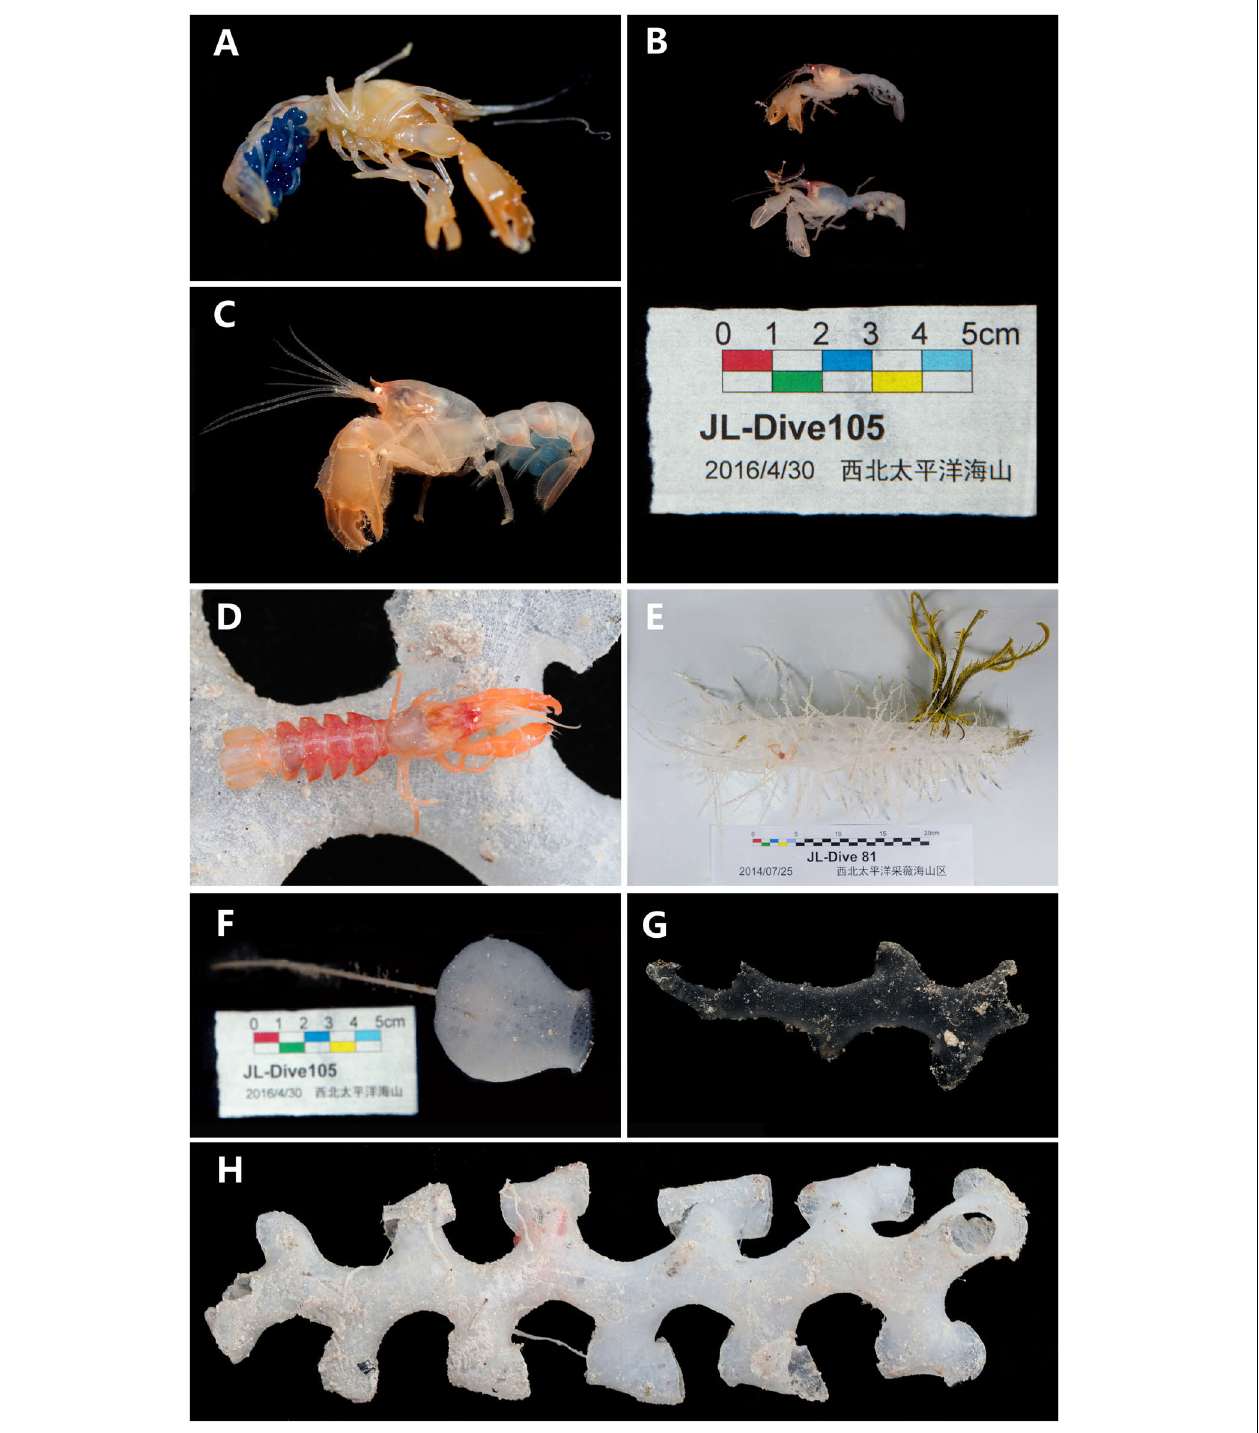
FIGURE 6 | (A) Eiconaxius serratus sp. nov. Holotype, SRSIO 14070301 (ovigerous female, cl 9.0 mm), color in life; (B) Eiconaxius serratus sp. nov. Paratypes, SRSIO 16040301 (ovigerous female, cl 7.1 mm) and SRSIO 16040302 (male, cl 7.3 mm), color in life; (C) Eiconaxius serratus sp. nov. Non-type, MBM 304669 (ovigerous female, cl 7.8 mm), color in life; (D) Eiconaxius serratus sp. nov. Non-type, MBM 304668 (ovigerous female, cl 10.0 mm), color in life; (E) host sponge of holotype (SRSIO 14070301), Corbitellinae gen. sp. (Lyssacinosida, Euplectellidae); (F) host sponge of paratypes (SRSIO 16040301 and 16040301), Amphidiscella sp. (Lyssacinosida, Euplectellidae, Bolosominae); (G) host sponge of non-type (MBM 304668), Farrea sp. (Sceptrulophora, Farreidae); (H) host sponge of non-type (MBM 304669), Farrea sp. (Sceptrulophora, Farreidae).